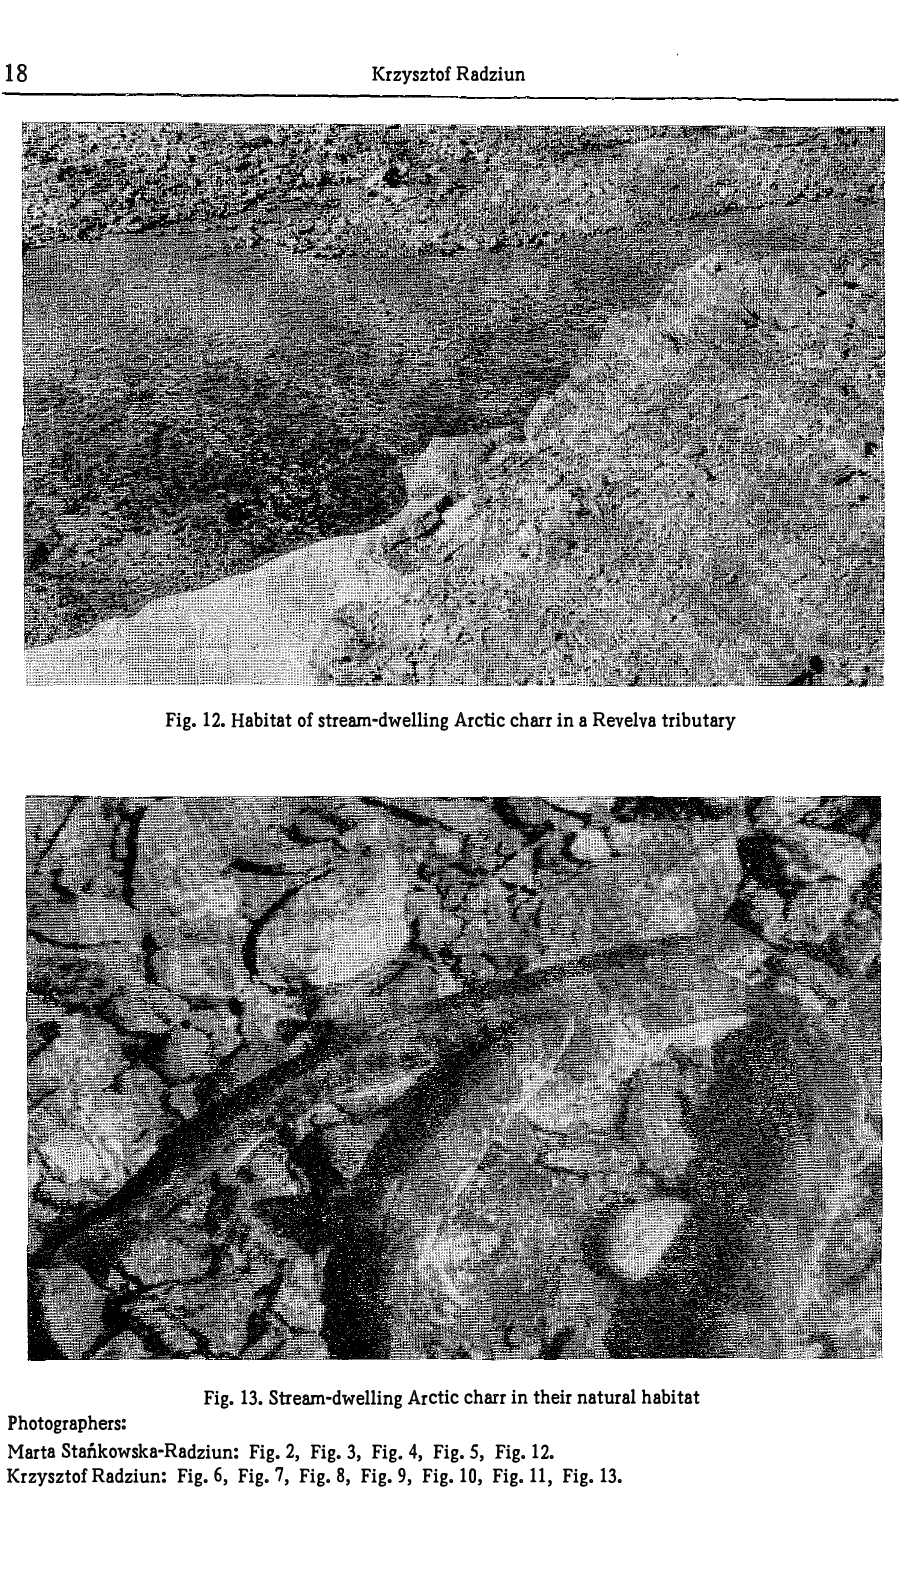
Fig. 13. Stream-dwelling Arctic charr in their natural